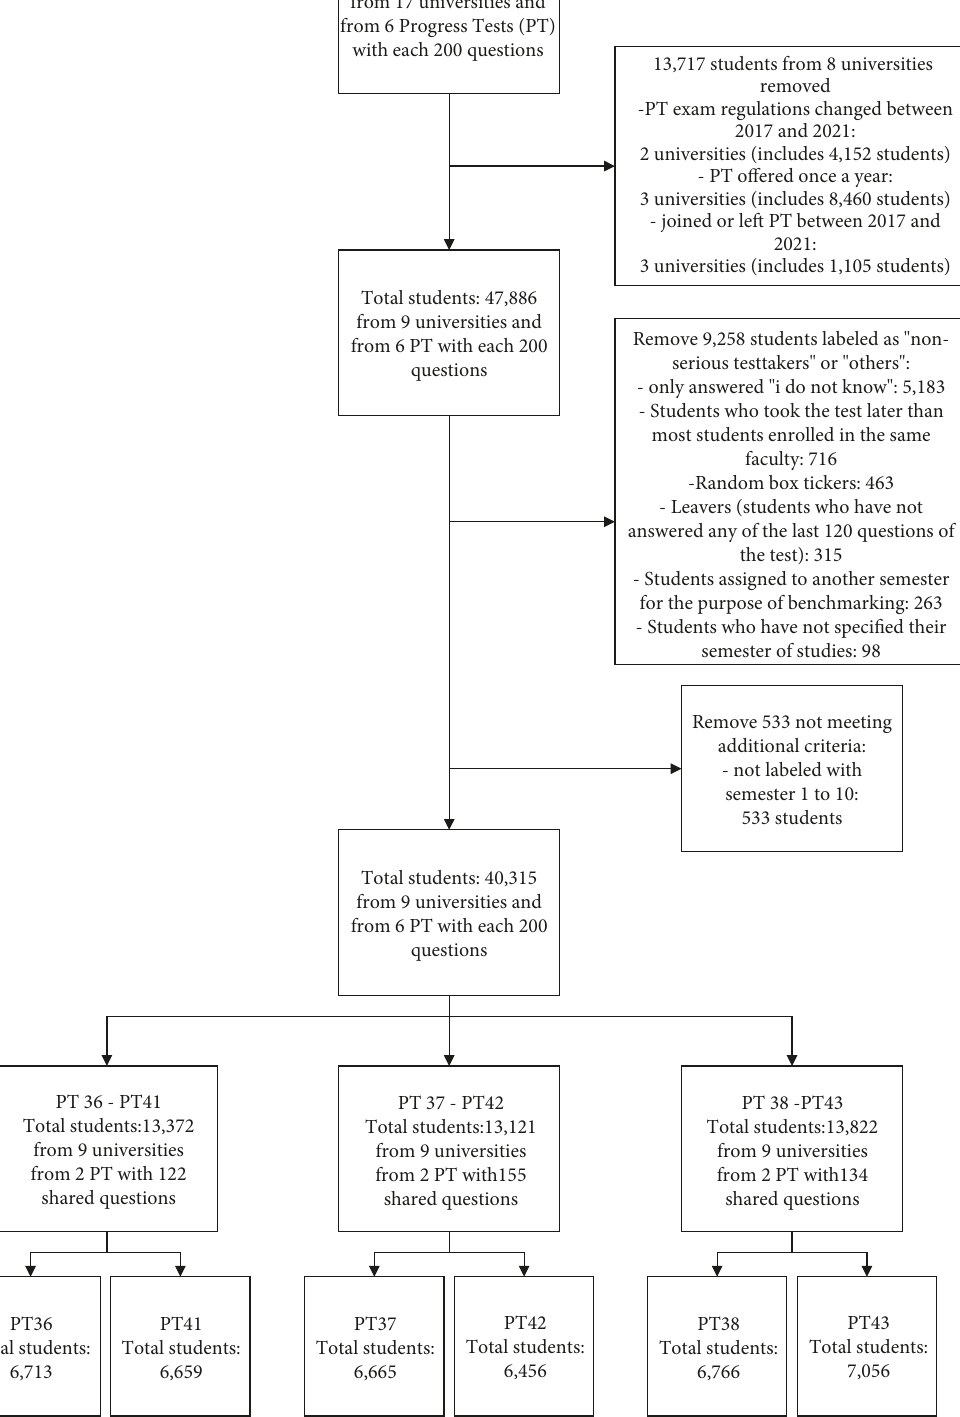
Figure 1: Flowchart of data cleaning process and allocation into different PT